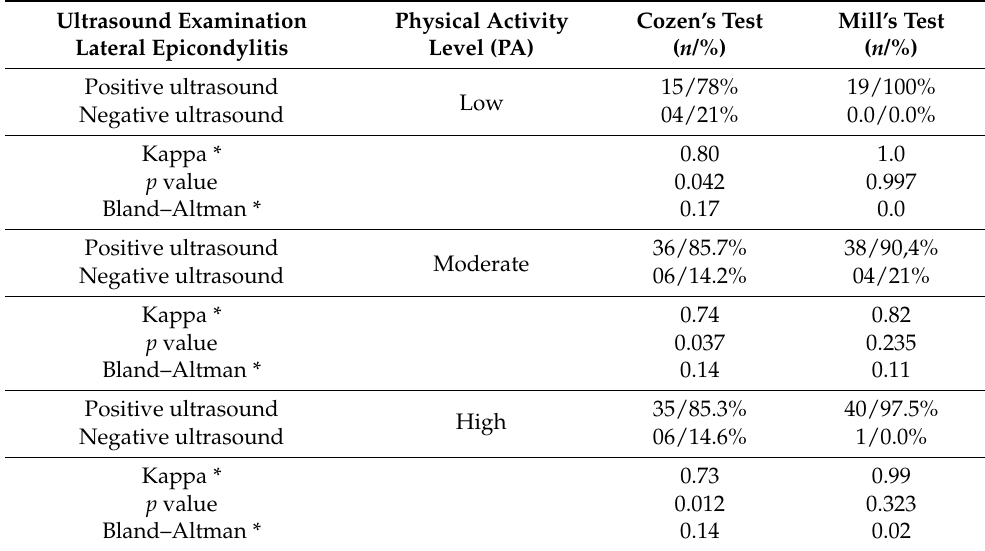
Table 4. Agreement index of clinical tests with “gold standard” ultrasound examination in confirming the diagnosis of lateral epicondylitis in